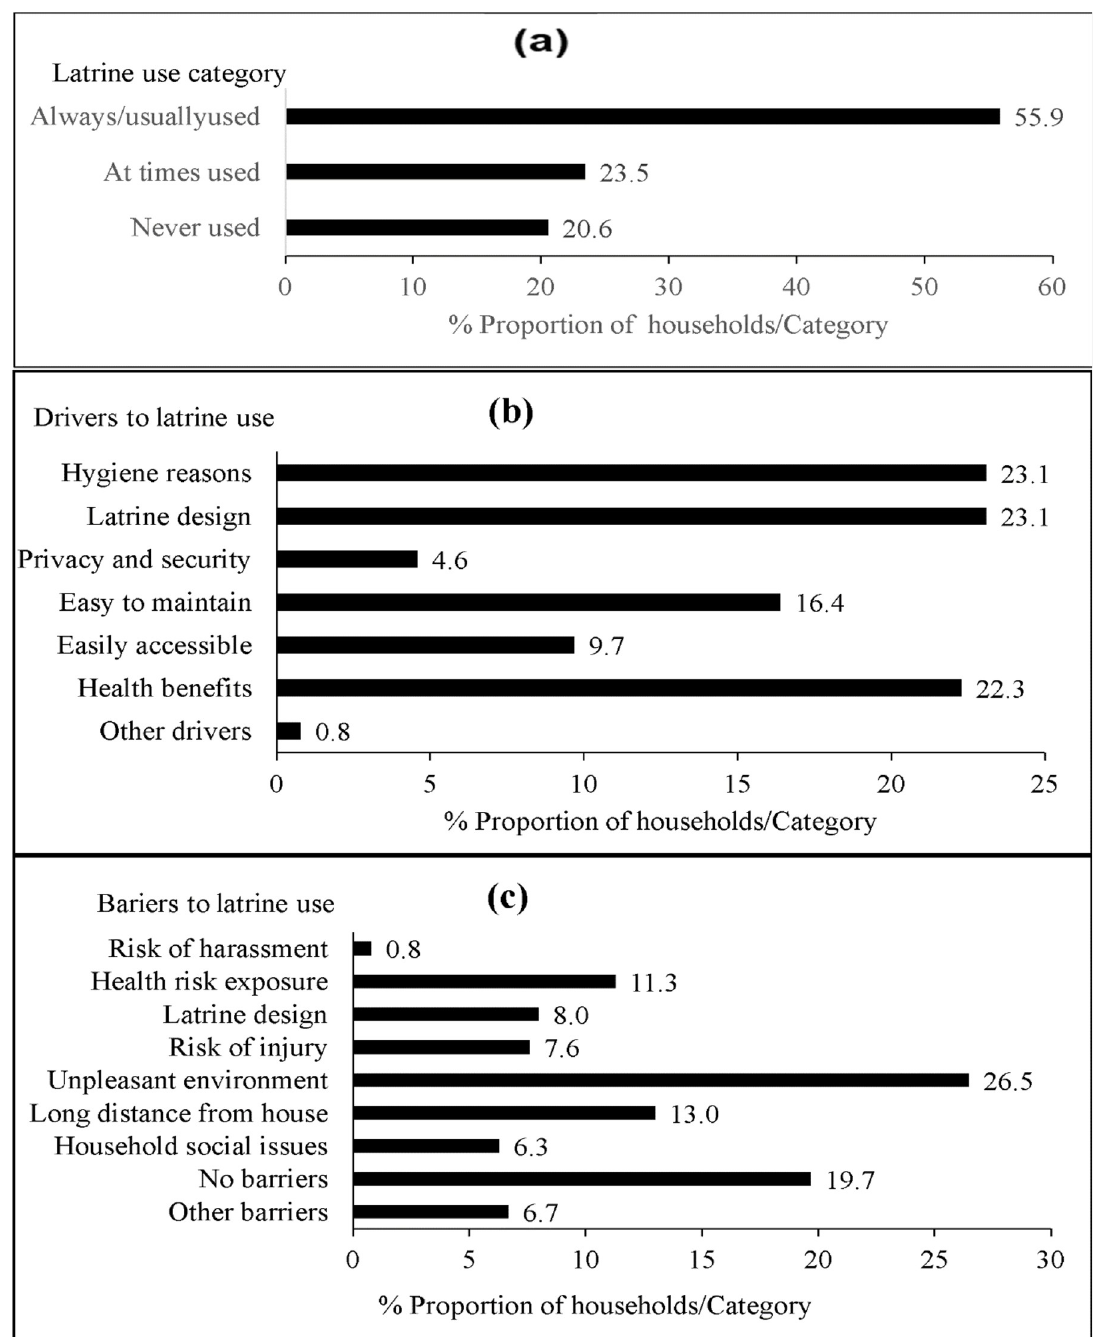
Fig 3. Latrine use in the previous week (a), drivers (b), and barriers (c) to sustained latrine use among households owning BVIP latrines in Mbire district, northern Zimbabwe, 2021. Household-level predictors included households with a monthly income of 51–100 USD which were significantly 4.79 times more likely than those with less than 50 USD to demon- strate the intention to adapt their latrines to climate change (OR = 4.790, p = 0.002, 95% CI = 1.775, 12.927). Increased likelihood of the intention to adapt the BVIP latrine was evident